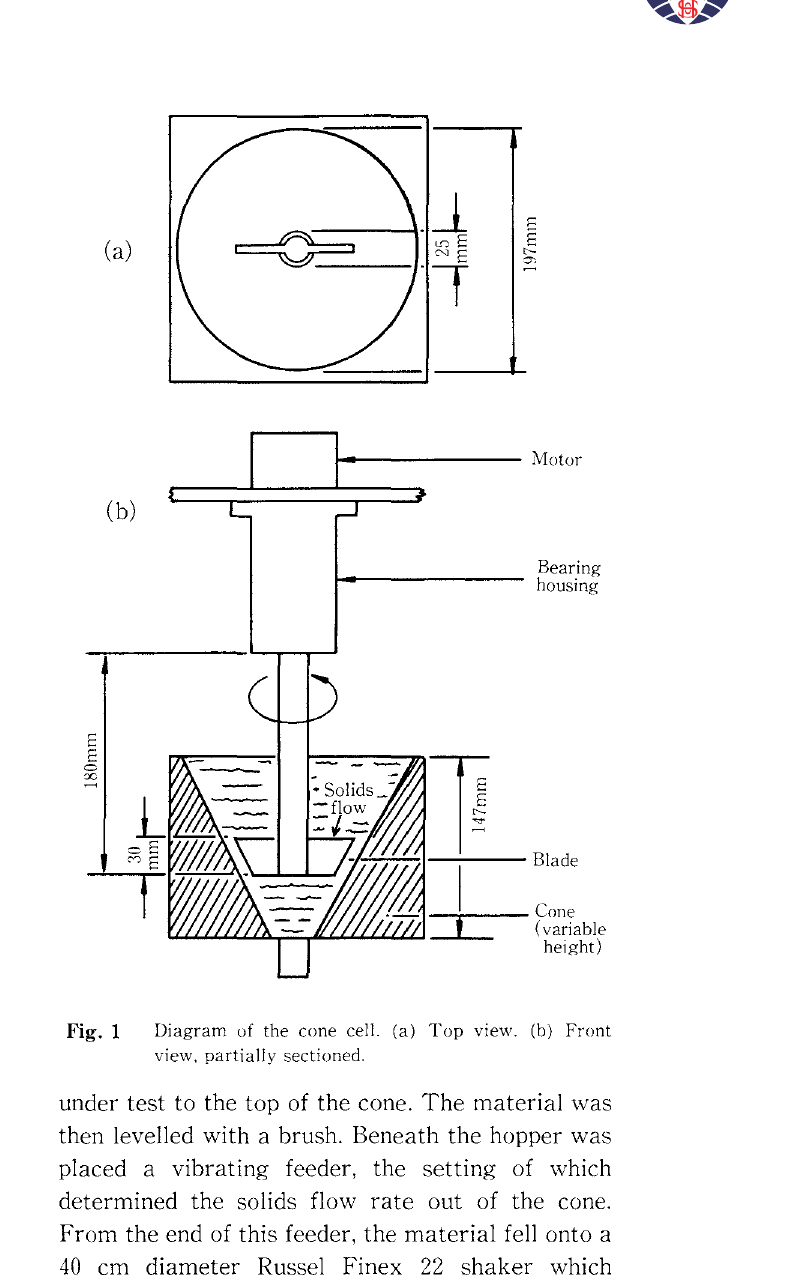
Diagram of the cone cell. (a) Top view. (b) Front view. partially